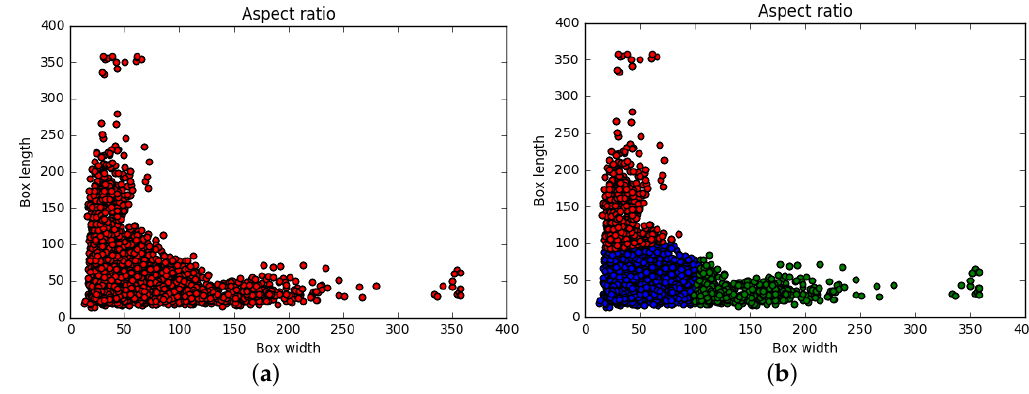
Figure 2. Aspect ratio. ( a ) Original aspect ratio, ( b ) aspect ratio after K-Means clustering.